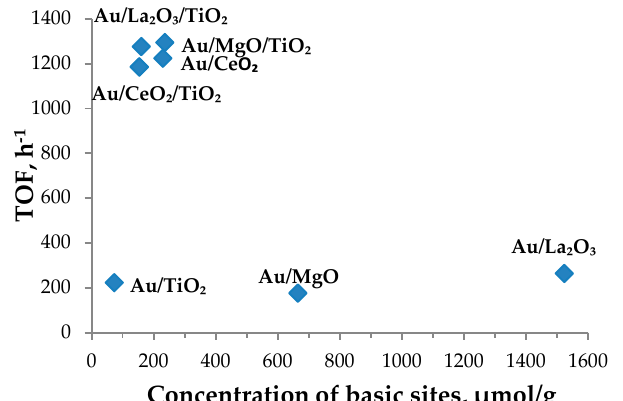
Figure 4. Concentration of basic sites and TOF in glycerol oxidation for gold supported catalysts.